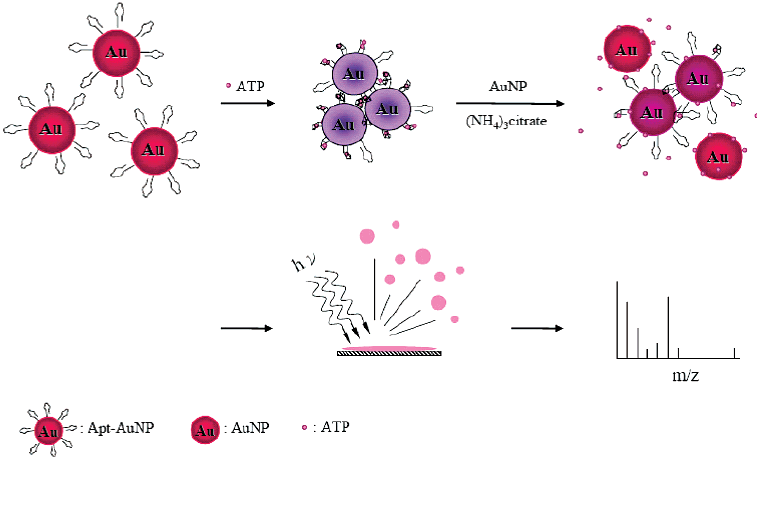
Figure 2. Illustration of the interactions of ATP with Apt-Au NPs and Au NPs. Reprinted with permission from Reference